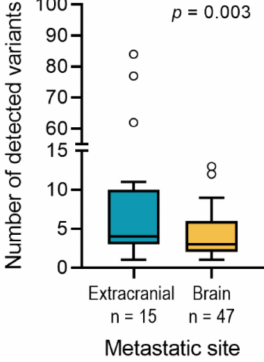
Figure 3. Box and whiskers plot showing the sum of called variants in extracranial and brain meta-static tissues including unpaired samples. The number of detected variants were summed and plotted in extracranial metastases (mean: 17, median: 4, range: 1–83) and in brain metastases (mean: 4, median: 2, range: 1–12). p -value indicates two-sided unpaired t -test.